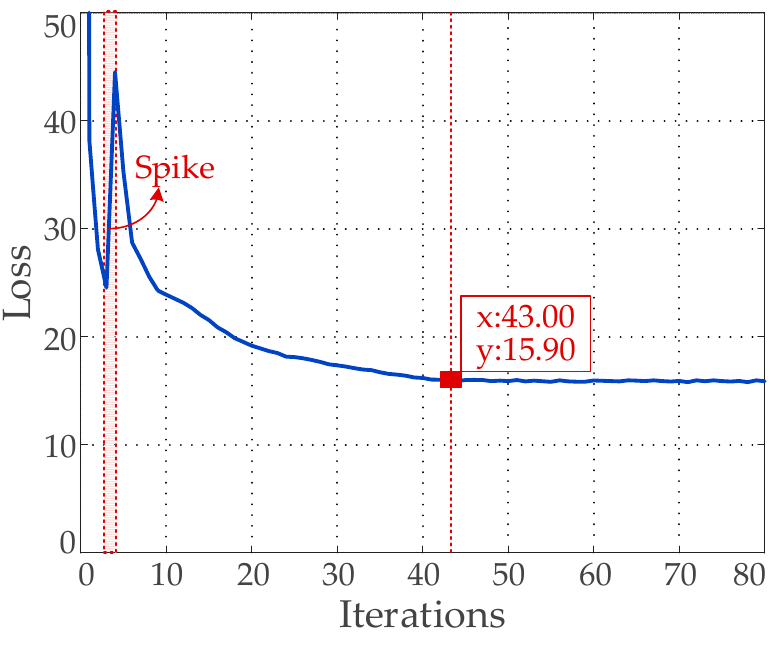
Figure 6. Loss trend curve.